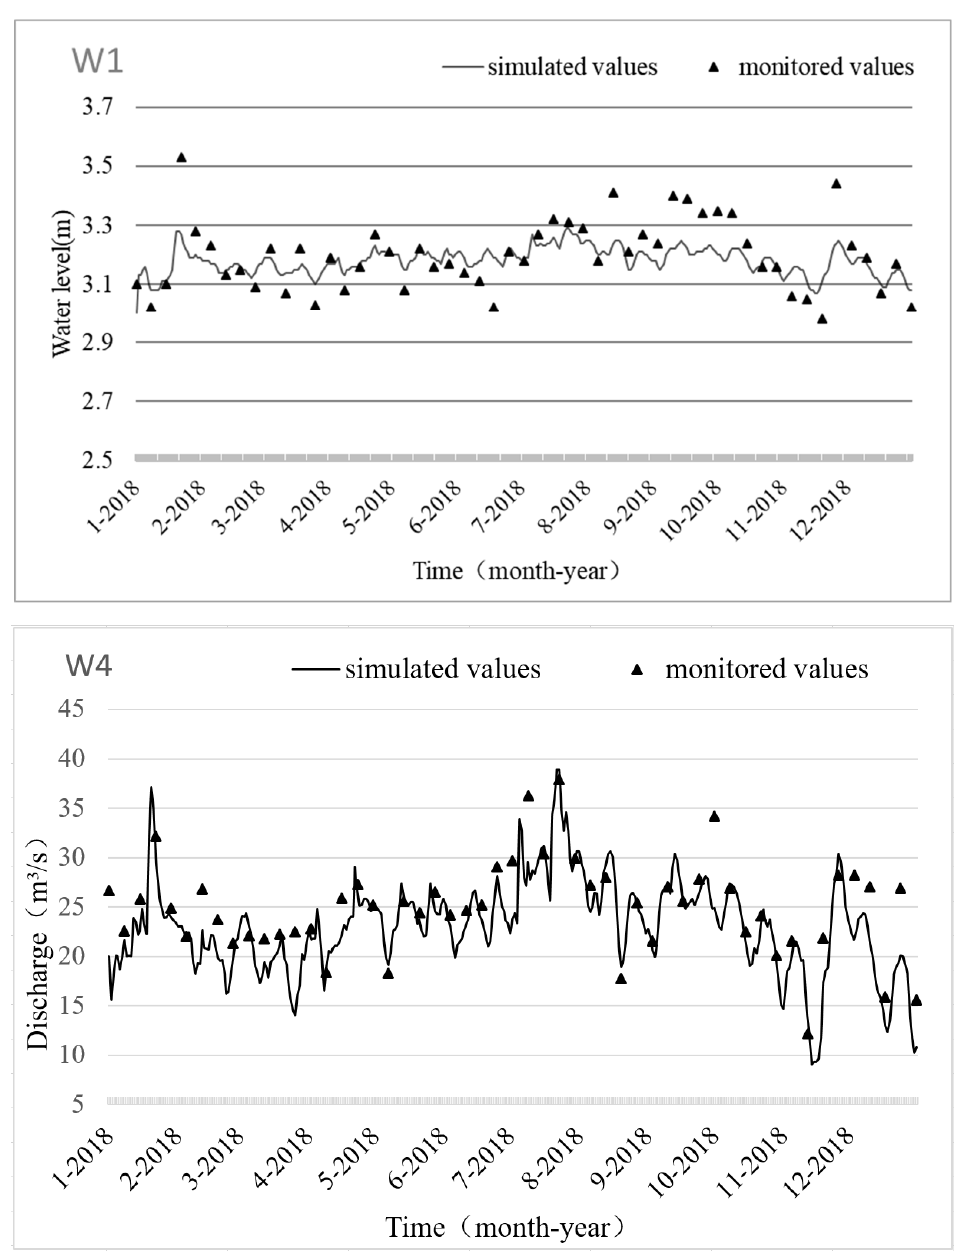
Figure 3. Comparison of simulated and monitored values of water levels and discharges.